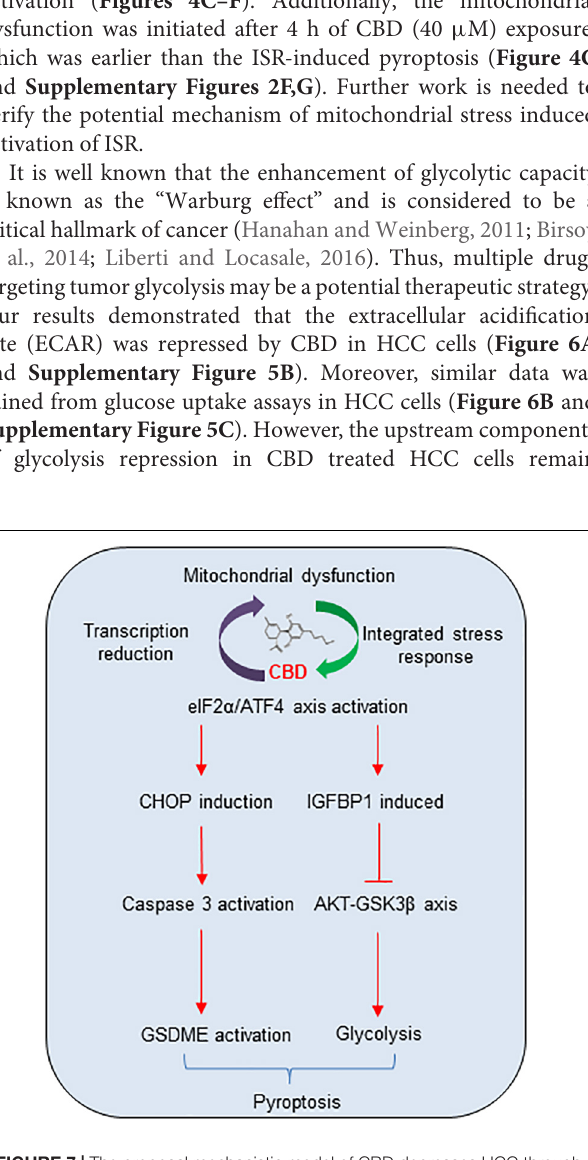
Frontiers in Cell and Developmental Biology |